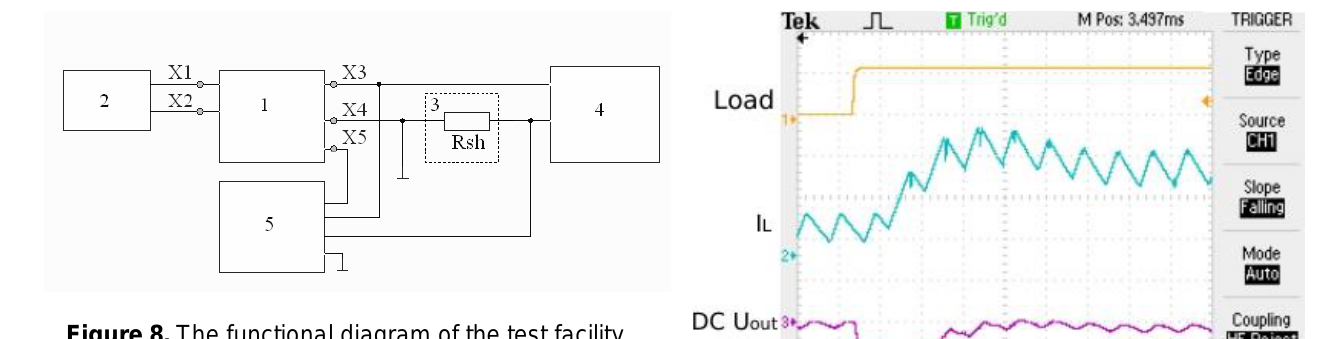
Figure 8. The functional diagram of the test facility The test facility includes: buck converter prototype (1), power supply with adjustable supply voltage range from 40 V to 110 V (2), current sensor in the form of a resistive Rsh shunt with a resistance of 0.2 Ohm (3), a load unit consisting from constantly connected and periodically switched resistors (4) and a four-channel oscilloscope (5). The results of studying the buck converter prototype are shown in Figures 9–11.